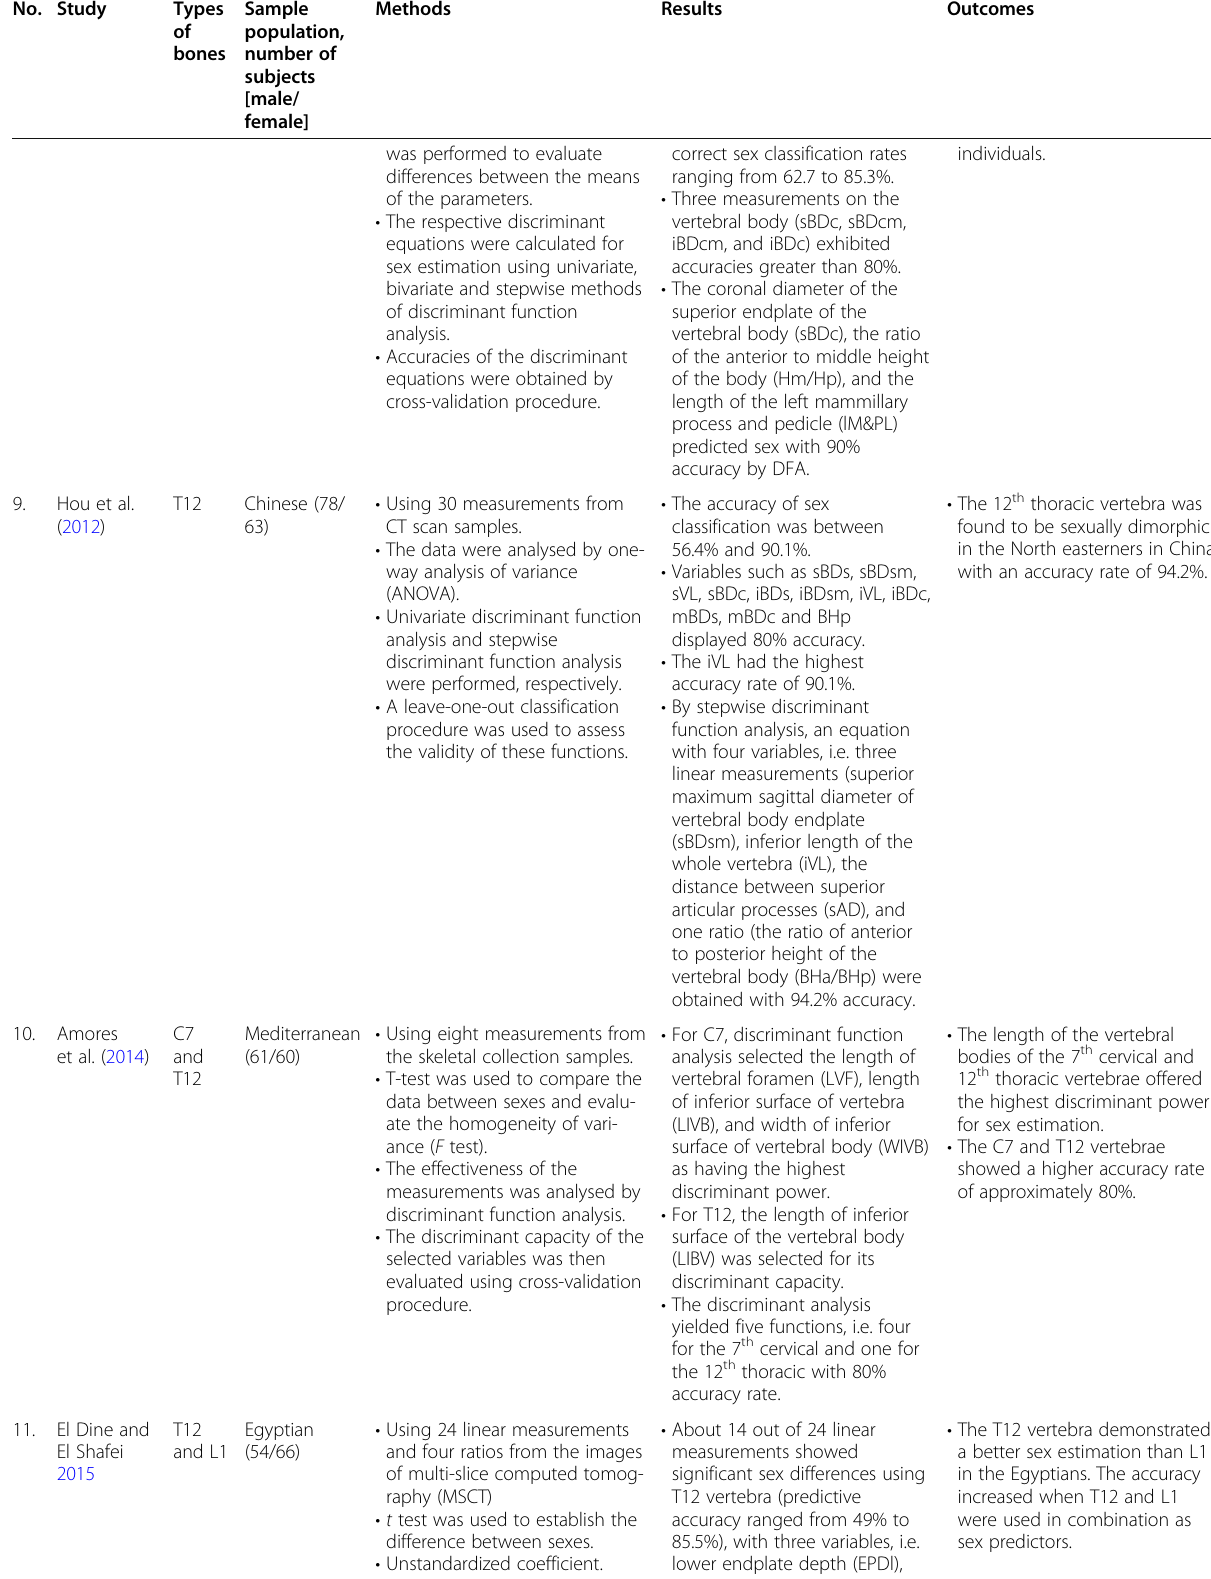
Table 1 The descriptive studies on sexual dimorphism in vertebral bone (Continued) No.